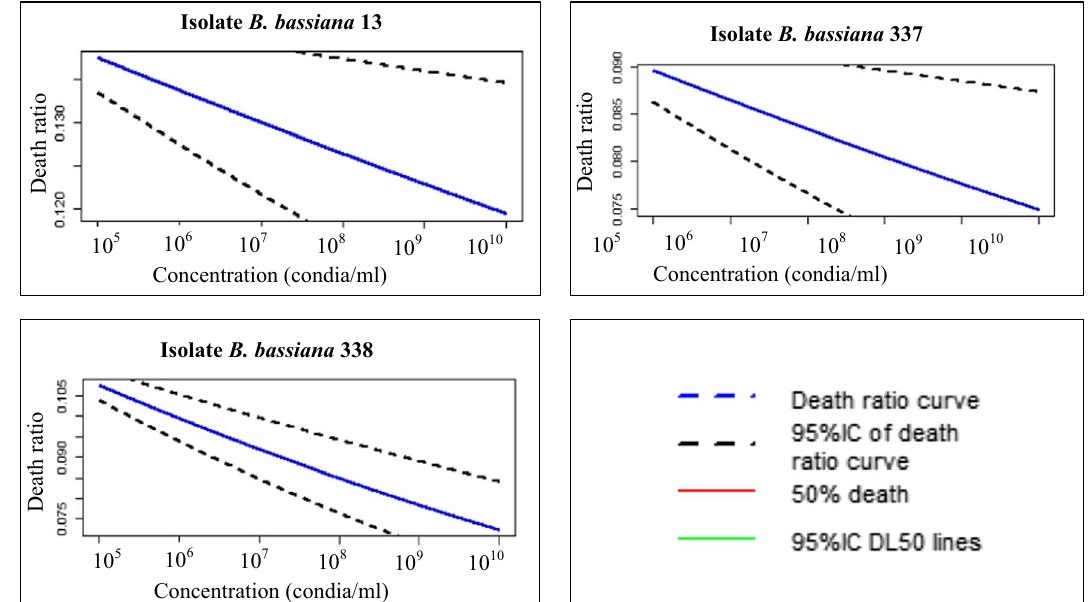
Fig. 10 LC50 values after treatment of the larvae of Zeugodacus cucurbitae to various concentrations of Bb13, Bb337 and Bb338